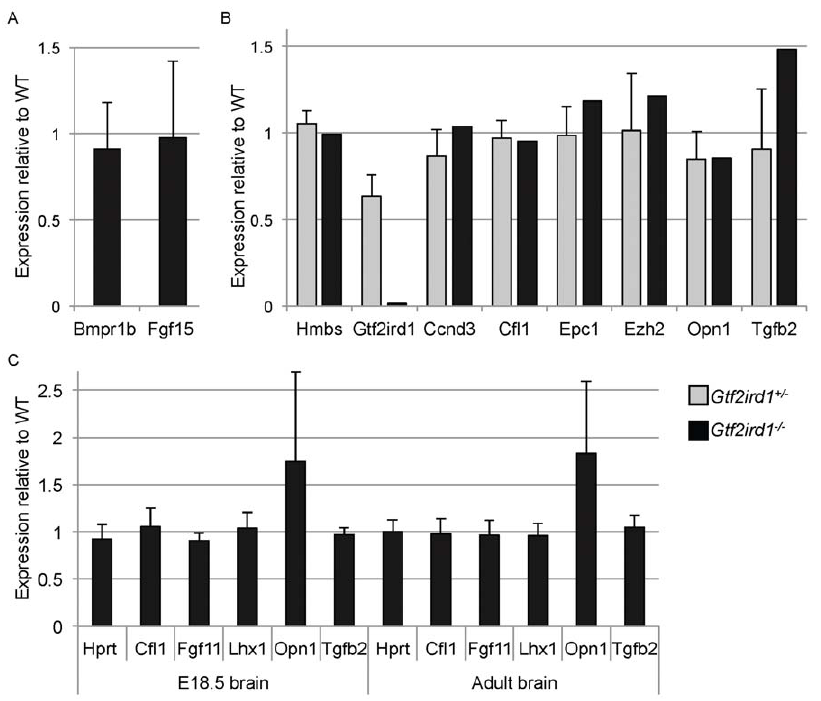
Figure 1. qRT-PCR validation of expression changes identified by microarray. Expression values were normalized to the housekeeping gene Sdha , and are depicted as a ratio of expression in Gtf2ird1 2 / 2 mice relative to WT littermates. * p , 0.05, ** p , 0.005 using Student’s t-test. A. Expression in whole brain from P0 mice. RNA from 9 mice of the same genotype was pooled together to make cDNA (n=3 pools/genotype). B. Expression in heads of E15.5 mouse embryos (n=5/genotype).